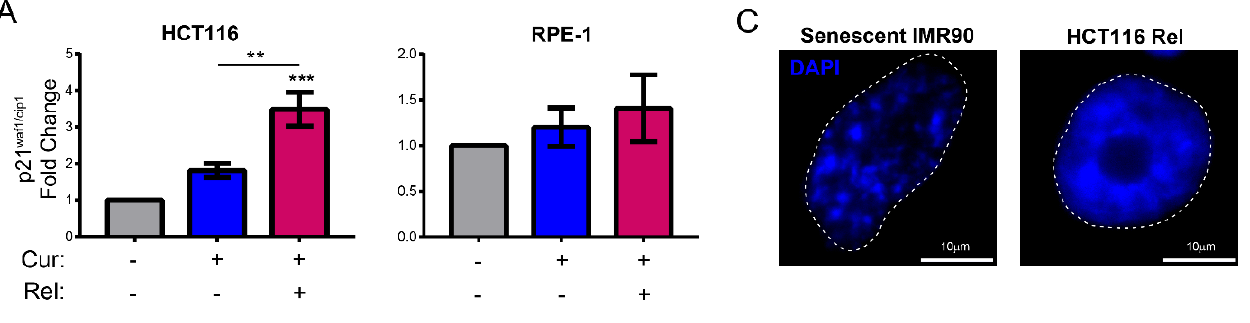
Figure 3. Curcumin-induced senescence correlates with p21 activation and global reduction in heterochromatin markers: ( A ) Histograms showing the expression of the p21 gene in HCT116/RPE- 1 Cur and Rel cells relative to control. n = 3. Un-paired t -test: *** p < 0.001, ** p < 0.01; ( B ) immunoblots of cell extracts with antibodies against p21. Antibodies against β -tubulin or actin are used as a loading control. Graphs summarizing the quantification of three independent experiments. Un- paired t -test: * p < 0.05; ( C ) representative DAPI-staining images of senescent IMR90 cells and HCT116 Rel cells. SAHF are visible only in senescent IMR90 nuclei, which are used as a control. n = 2. Scale bar = 10 µm; ( D ) representative immunofluorescence images showing the pattern of 5- methyl-cytosine (5MC) antibodies in HCT116 cells with the indicated treatment. Scale bar = 10 µm. Graph showing the global reduction in 5MC in HCT116 Rel cells. n = 3. Un-paired t-test: **** p < 0.0001; ( E ) representative immunofluorescence images showing the pattern of H3K9me3 antibodies in HCT116 cells with the indicated treatment. Scale bar = 10 µm. Graph showing the global reduction in H3K9me3 in HCT116 Rel cells. n = 3. Un-paired t-test: **** p < 0.0001.